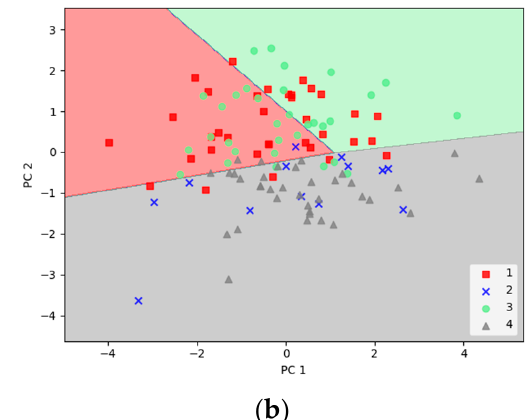
Figure 8. Data classification according to the environmental quality indexes determined according to PCA: ( a ) explained variance ratio of each principal component. This statistical chart presents the proportions of principal component PC1 and PC2 to certify that they are effective. If the proportion of the sum of PC1 and PC2 is lower than 0.3 (30%), then the principal component cannot certify that the classification is accurate; ( b ) decision-distribution map of component scatter plot. This scatter plot presents the check-in marks distributed according to the four class IDs on the 2D vector graphs constituted by PC1 and PC2. If the classification is accurate, then the scatter points should come together under the same class ID. This plot presents the classification output of at least three effective blocks on the PC1–PC2 graphics.